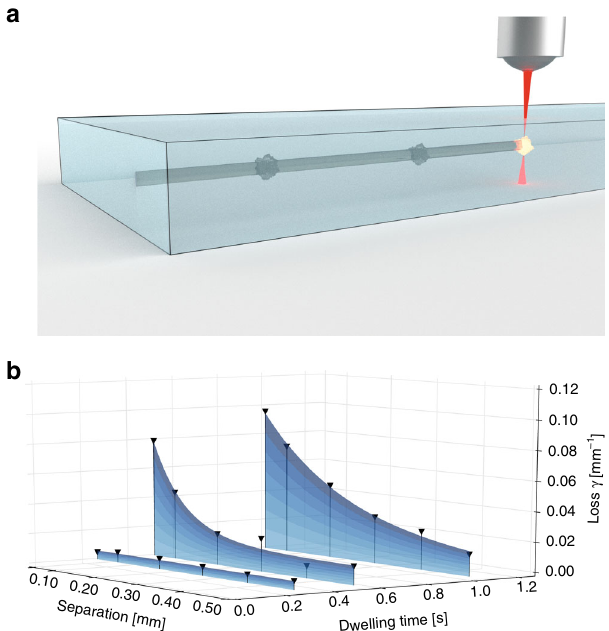
Fig. 2 Realizing arti fi cial loss. a Schematic of the arti fi cial scatterers introduced during the fabrication process by dwelling. b Experimentally obtainable arti fi cial losses as a function of dwelling time and separation of the scatter centers